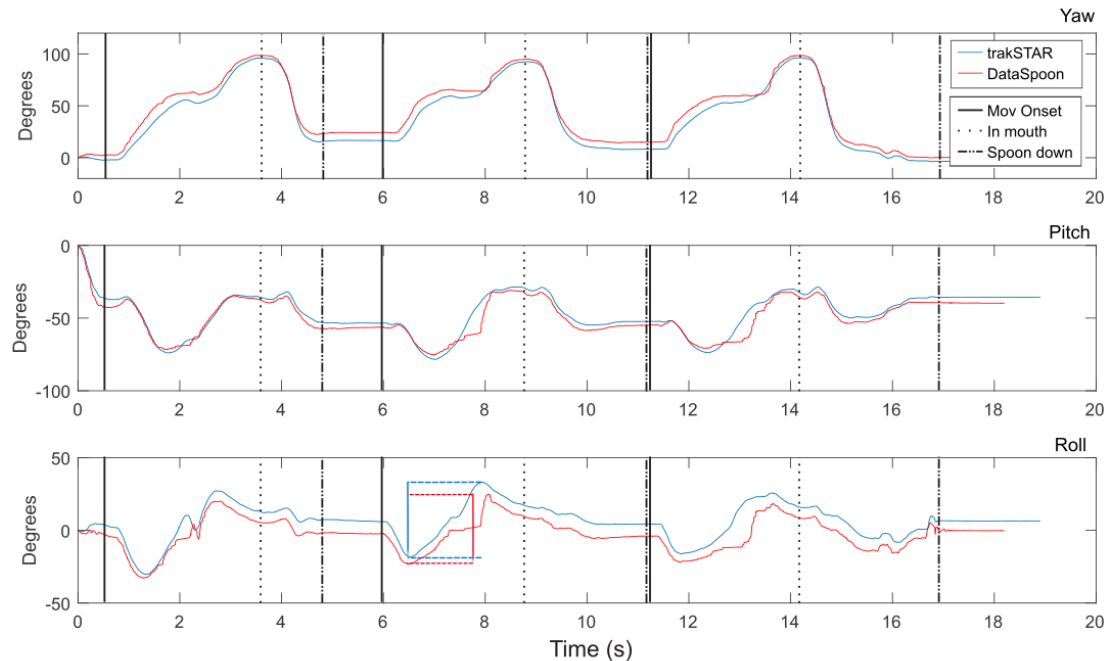
Figure 3. Yaw, Pitch and Roll angles for 3 consecutive eating cycles at natural spoon position and comfortable speed. trakSTAR (blue) and DataSpoon (red) signals were synchronized by a common movement of pitch at onset of recording. Black vertical lines indicate timing of eating cycle events identified for trakSTAR signals. Blue and red vertical lines (bottom panel) demonstrate the calculation of range (in this case - of roll) for one movement part.